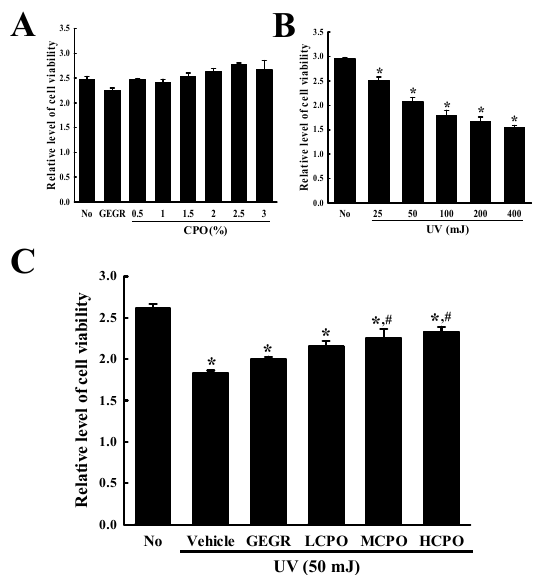
Figure 2. Viabilities of NHDF cells treated with UV and CPO. ( A ) Optimal CPO dose was determined using an MTT assay by treating cells with six di ff erent concentrations of CPO (0.5, 1, 1.5, 2, 2.5 and 3%). ( B ) Optimum UV dose was determined by exposing NHDF cells to UV at five levels (25, 50, 100, 200 and 400 mJ). ( C ) Viabilities of UV + CPO treated cells. After exposure 50 mJ of UV and treatment with di ff erent concentrations of CPO for 24 h, cell viability was measured using MTT assay. Two to three wells per group were MTT assayed and optical densities were measured in duplicate. Data are reported as the means ± SD. * p < 0.05 compared to the No group. # p < 0.05 compared to the UV + Vehicle group. Abbreviations: LCPO, low concentration CPO; MCPO, medium concentration CPO; HCPO, high concentration CPO; GEGR, gallotannin-enriched extract of Galla